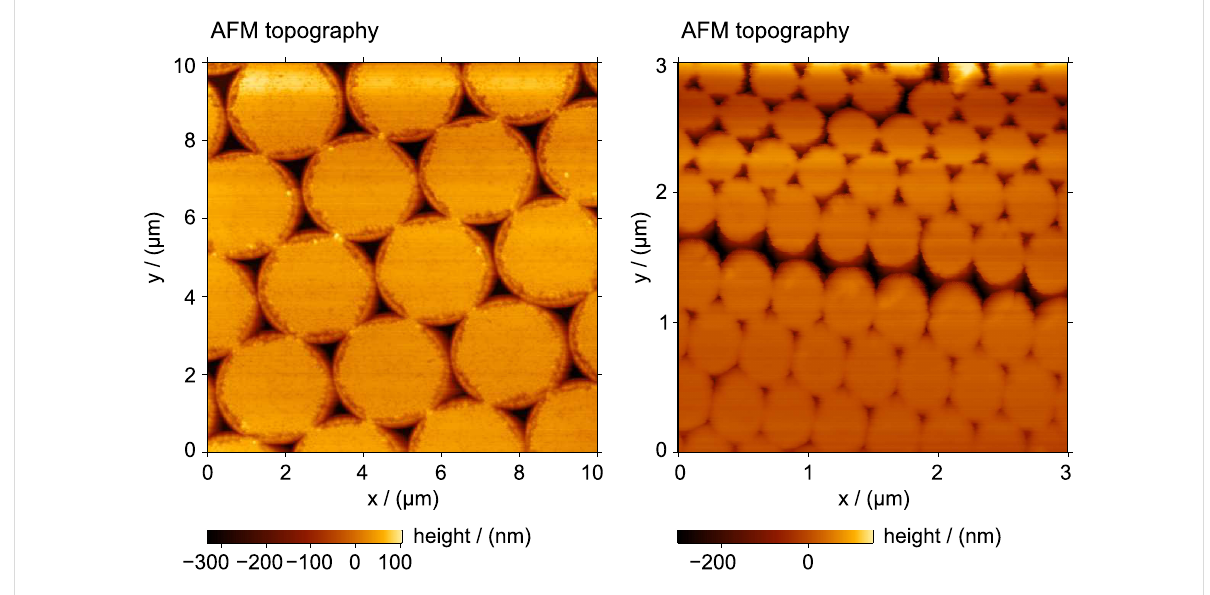
Figure 7: Arrays of triangular holes in 180 nm thick gold film. Monolayer colloidal crystals of 3 μ m (left) and 400 nm (right) PS spheres were used as templates for the fabrication. The progressive degradation of quality in the topography of the right image is due to the reduction of the tip radius of the cantilever during scanning.